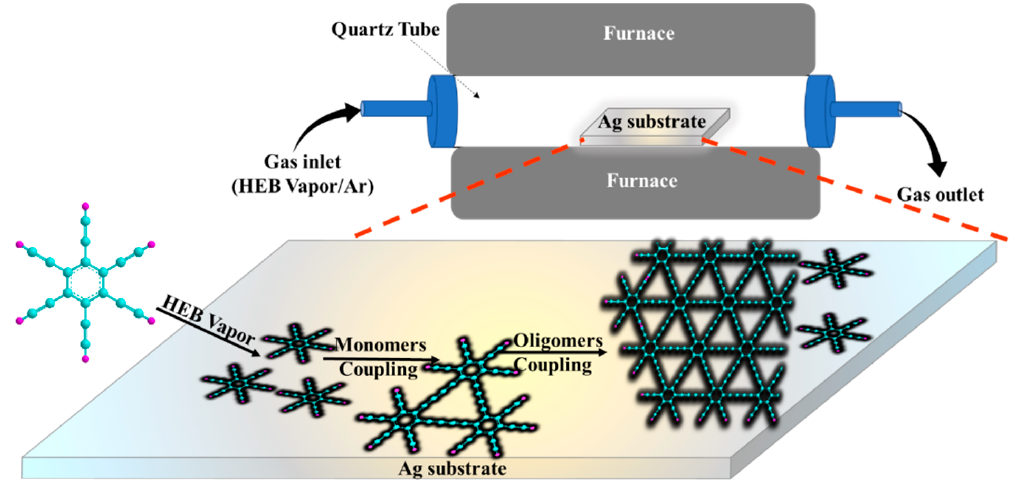
Figure 8. The formation of the GDY sheets on the silver surface with the aid of the CVD technique. Redrawn [86].